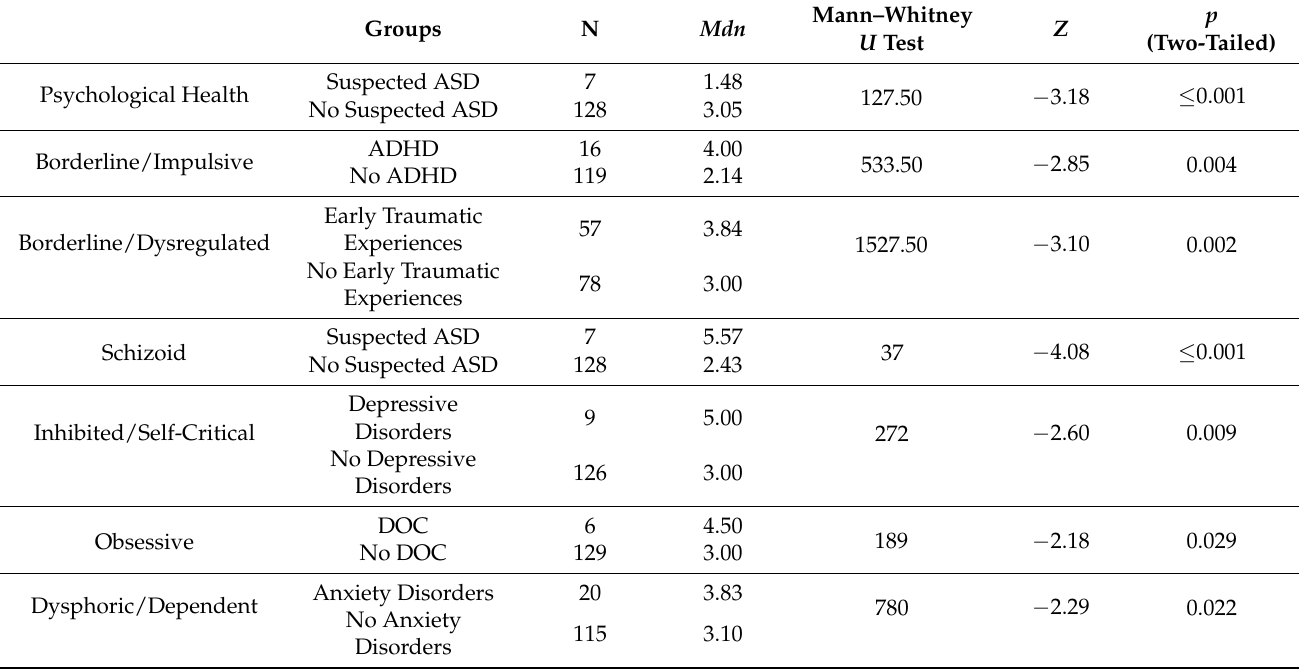
Table 9. Differences of CPAP-Q a personality prototypes in relation to specific demographic and diagnostic